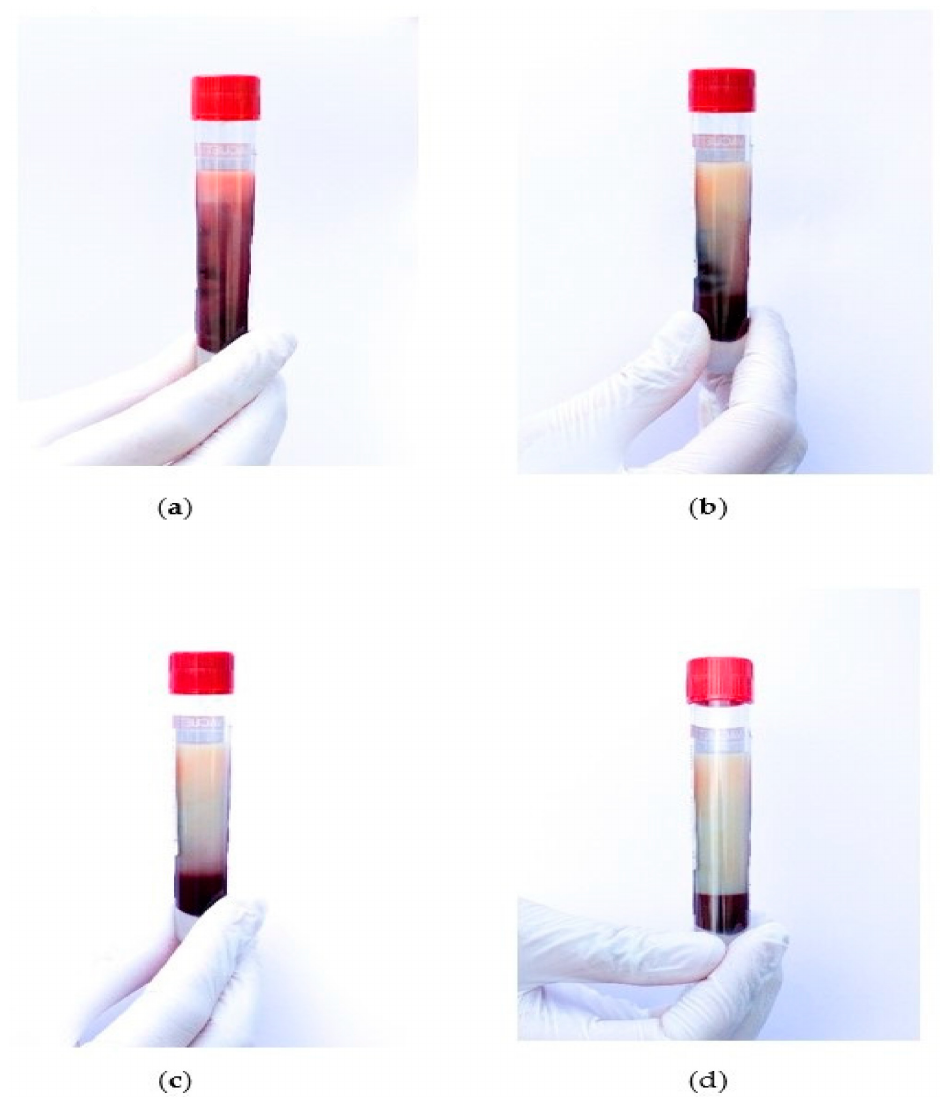
Figure 1. Lipemic plasma distribution in an EDTA tube ( a ) immediately after blood sampling ( b ) after 1 h ( c ) after 2 h ( d ) after 3